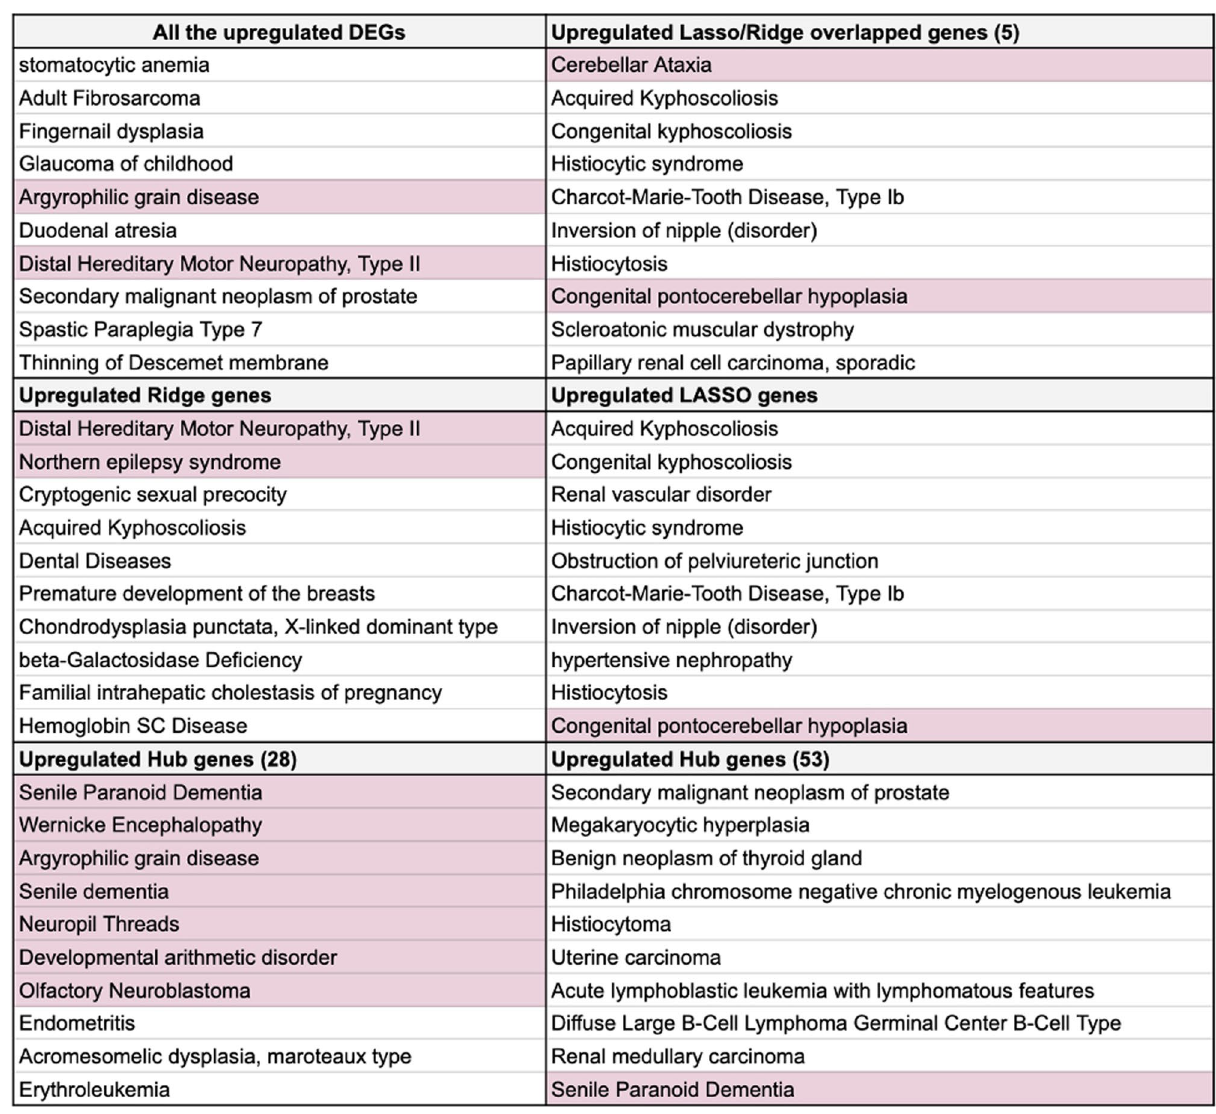
Figure 5. The top-10 enriched diseases retrieved from DisGeNET for upregulated genes in the different gene sets, including the DEGs, LASSO, Ridge, and the overlapped/common hub and feature selection